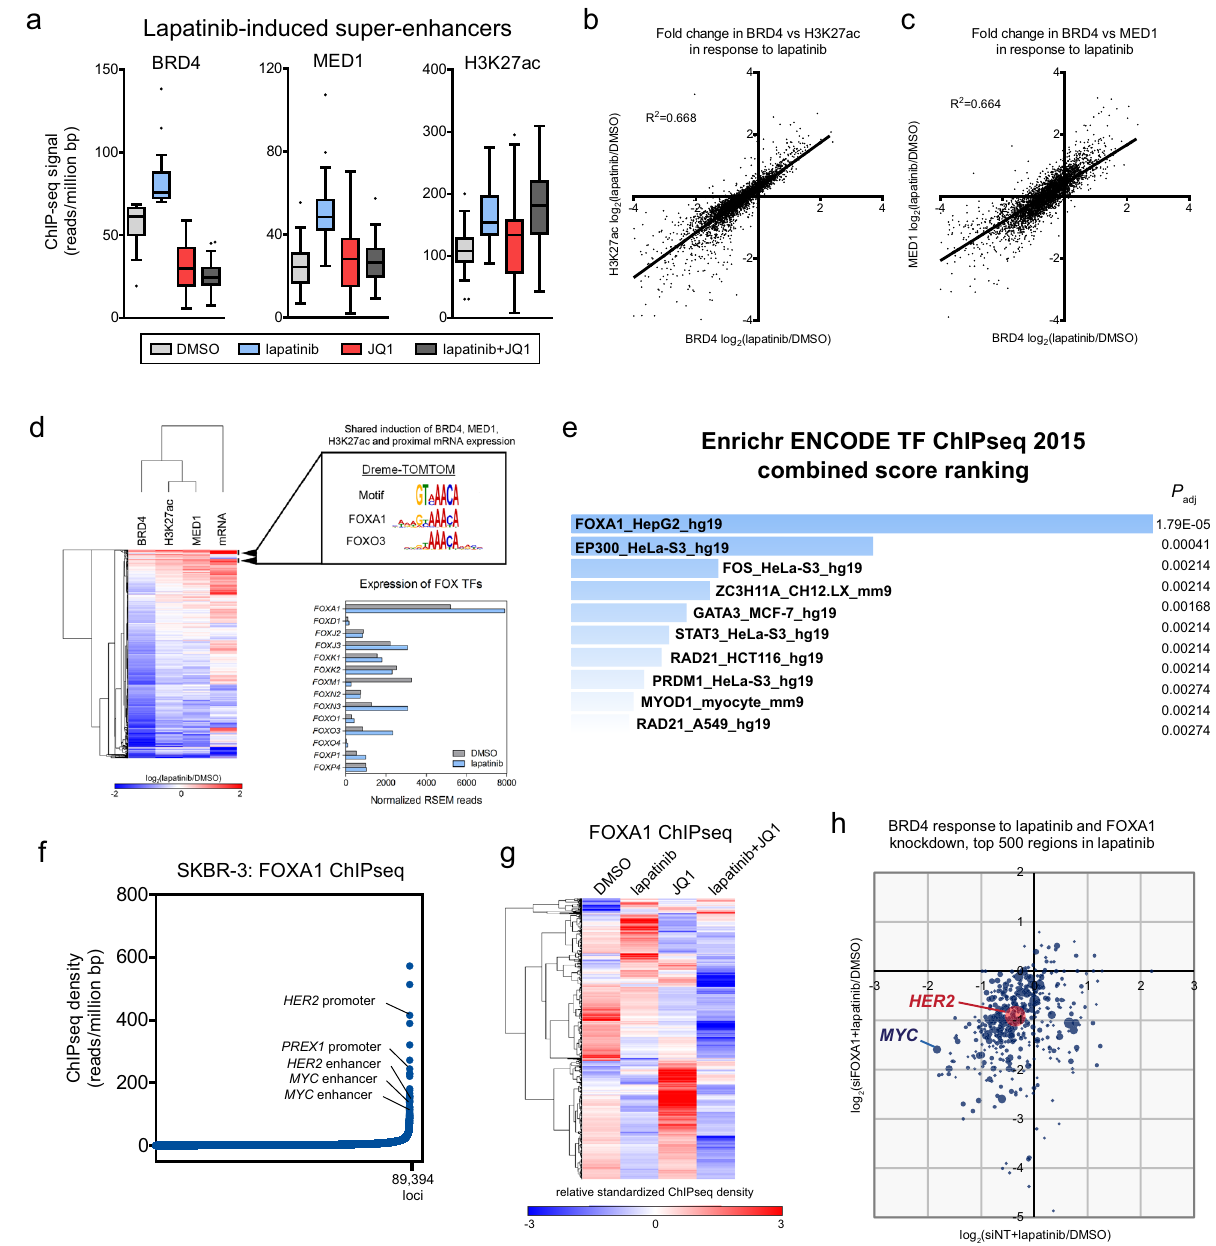
Fig. 2 Lapatinib-induced ChIPseq and RNAseq changes are associated with FOX family transcription factors. a Lapatinib induces 30 SEs, as determined by BRD4 ChIPseq density. Lapatinib in combination with JQ1 suppresses BRD4 binding in all regions, MED1 in all but one region, but does not affect H3K27Ac. Box plots: median, upper/lower quartile, and 1.5 IQR. b , c Lapatinib-mediated changes are strongly correlated with changes in H3K27Ac and MED1. d The log 2 fold change binding in response to lapatinib for regions as in ( a ) and the log 2 fold change in mRNA expression for the proximal genes as determined by RNAseq was used for unsupervised hierarchical clustering. Genes included based on ChIPseq density displayed increased chromatin association within 200 kb of transcription start site. Genes with shared induction in all instances (log 2 fold change ≥ 1) were used as input for Dreme-TOMTOM analysis to identify enriched binding motifs. A single motif identi fi ed, GT(A/C)AACA, recognized by FOXA1 and FOXO3. Normalized RNAseq reads are shown for the FOX family of transcription factors in SKBR-3 cells after 48 h treatment with DMSO or 300 nM lapatinib. e Genes from ( d ) were used to query Enrichr. ENCODE TF ChIPseq data identi fi ed FOXA1 and p300 as potential factors. f ChIPseq analysis of FOXA1 binding in SKBR-3 cells with the regions of highest density annotated by proximal gene. g Unsupervised hierarchical clustering of FOXA1 ChIPseq density in SKBR-3 cells treated with DMSO, 300 nM lapatinib, and 300 nM JQ1, alone or in combination, at all genomic loci. Lapatinib and JQ1 each result in regions of increased FOXA1 chromatin binding. The combination of lapatinib and JQ1 results in broad disruption of FOXA1. h SKBR-3 cells were treated with siRNA pools, nontargeting (NT) control or FOXA1, prior to DMSO or 300 nM lapatinib treatment for 24 h and subsequent BRD4 ChIPseq analysis. The top 500 regions in lapatinib are plotted. Log 2 fold change of lapatinib vs. DMSO with a control siRNA pool are plotted on the x-axis. Log 2 fold changes of lapatinib vs. DMSO with FOXA1 knockdown are plotted on the y-axis. Dots are scaled relative to their lapatinib-induced ChIPseq